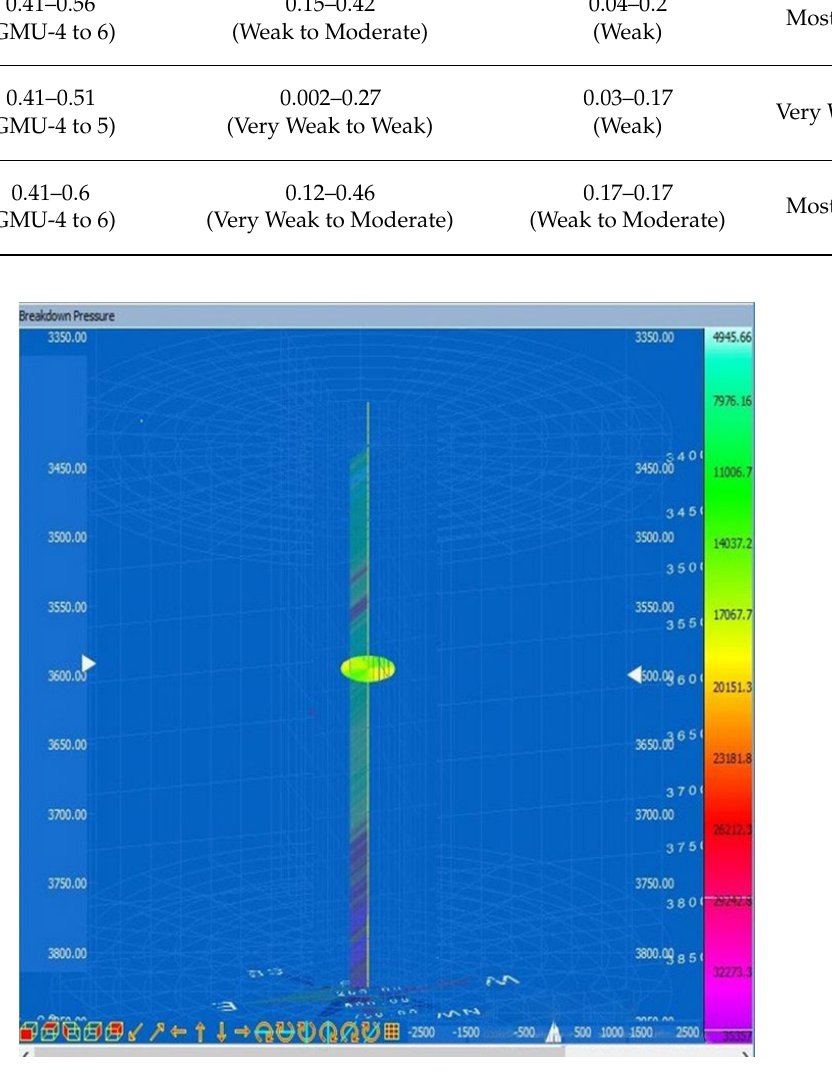
Figure 7. Breakdown pressure for the investigated well.